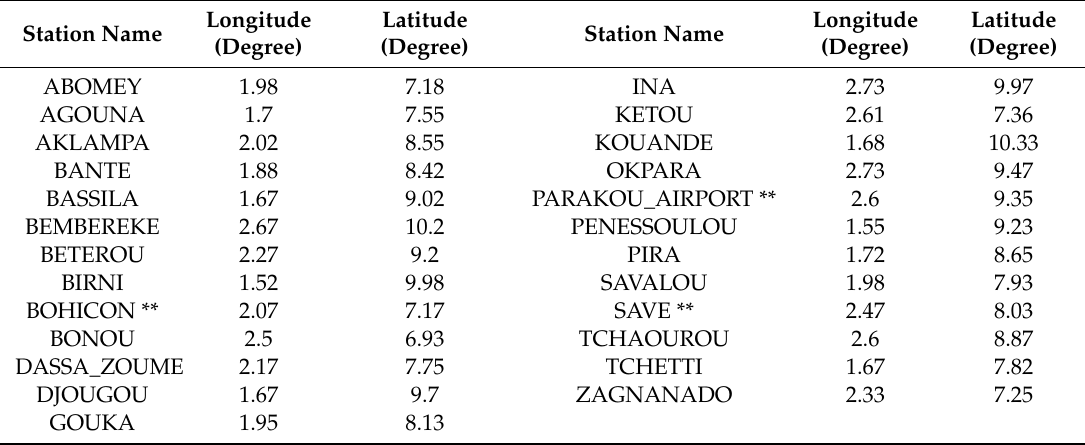
Table 2. Rain gauges and synoptic stations geographical position details.